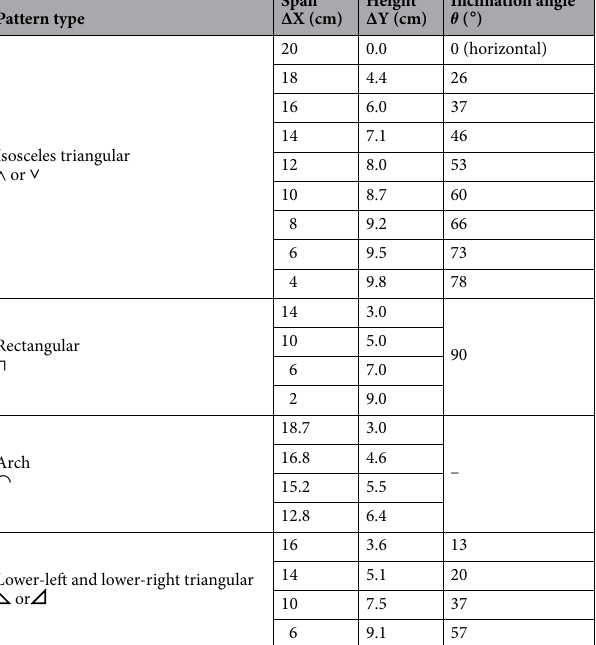
Table 2. Configurations of path shapes for fire